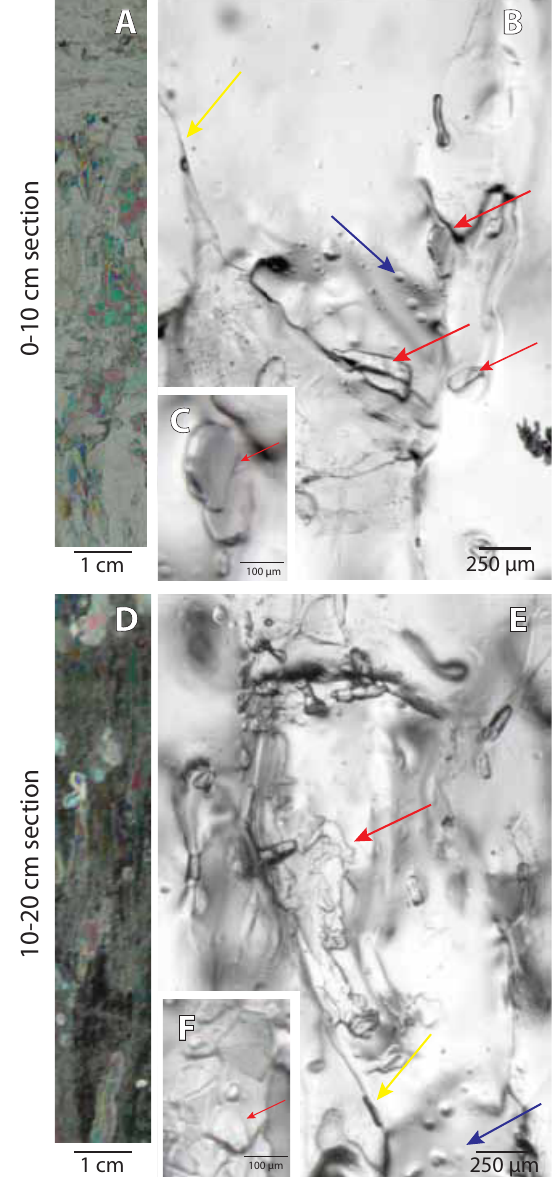
Fig. 3. Images of sea ice with ikaite crystals, from ICE I. (A, D) Sea ice texture (polarized light); (B, E) microscopic images of sea ice. Yellow arrows point to ice crystal borders, blue arrows to brine pockets, green arrows to air bubbles and red arrows to ikaite crys- tals. (C, F) Ikaite crystals at higher magnification. (A) , (B) and (C) from 10–20cm section; (D) , (E) and (F) from 49–59cm section.